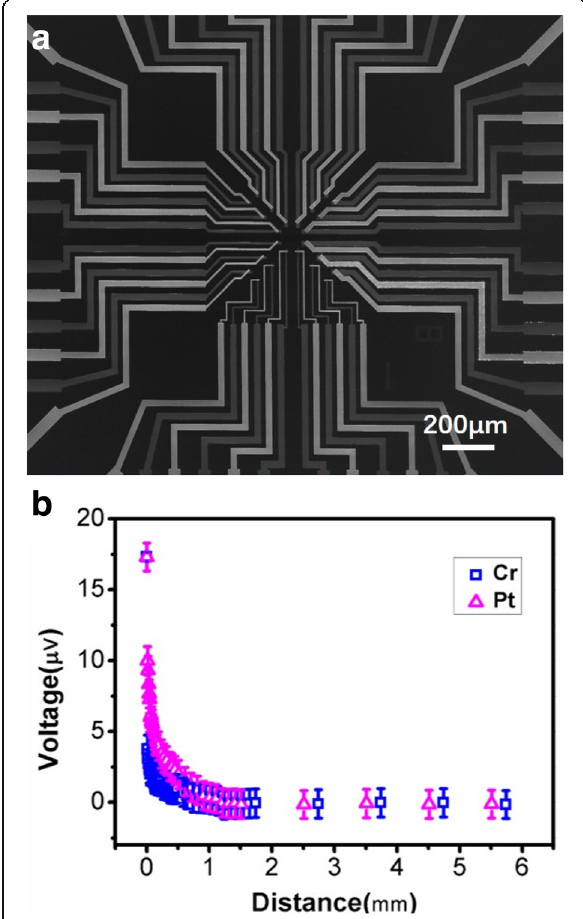
Fig. 6 A TFTC array and its measurement results. a SEM image of a Pt-Cr TFTC array sample on the front surface of a Si 3 N 4 /Si(100)/Si 3 N 4 wafer. The TFTC array on the central of the device consisted of 24 TFTCs, which had junction size ranged from 2.0×2.5 to 8.0×8.5 μ m 2 . b Measured outputs from one TFTC sensor when a focused e-beam of diameter 1 micro was irradiating on a spot of the two metallic thin film stripes of the TFTC, namely Pt and Cr, at certain distance to the Pt-Cr junction